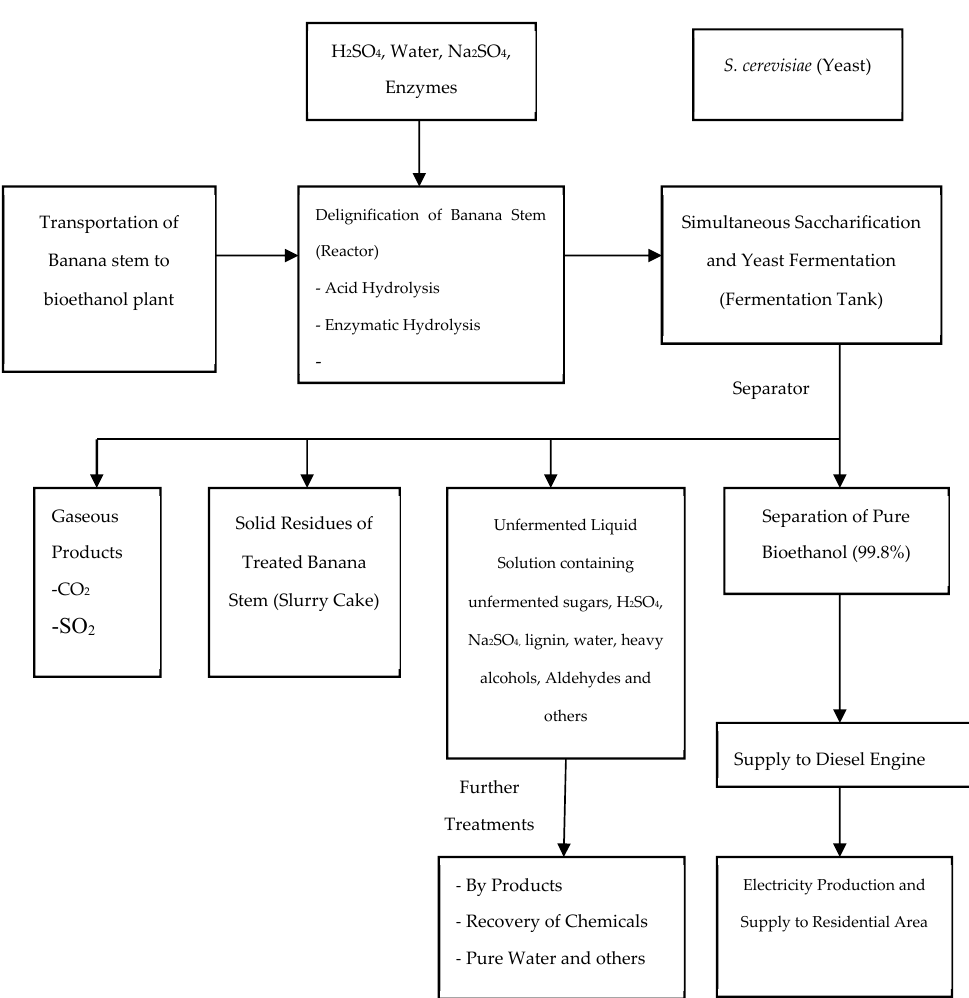
Figure 1. Technical flowsheet of banana stem-bioethanol-electricity supply.